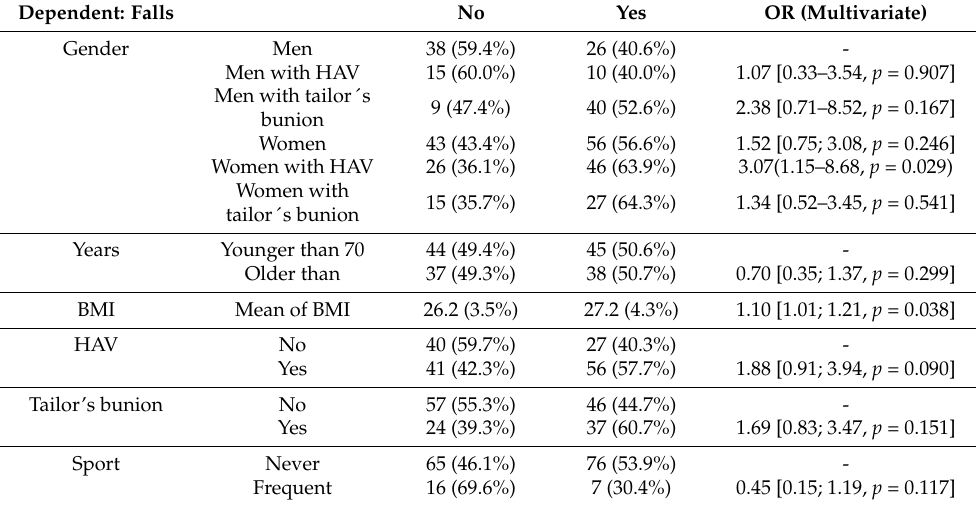
Table 3. General